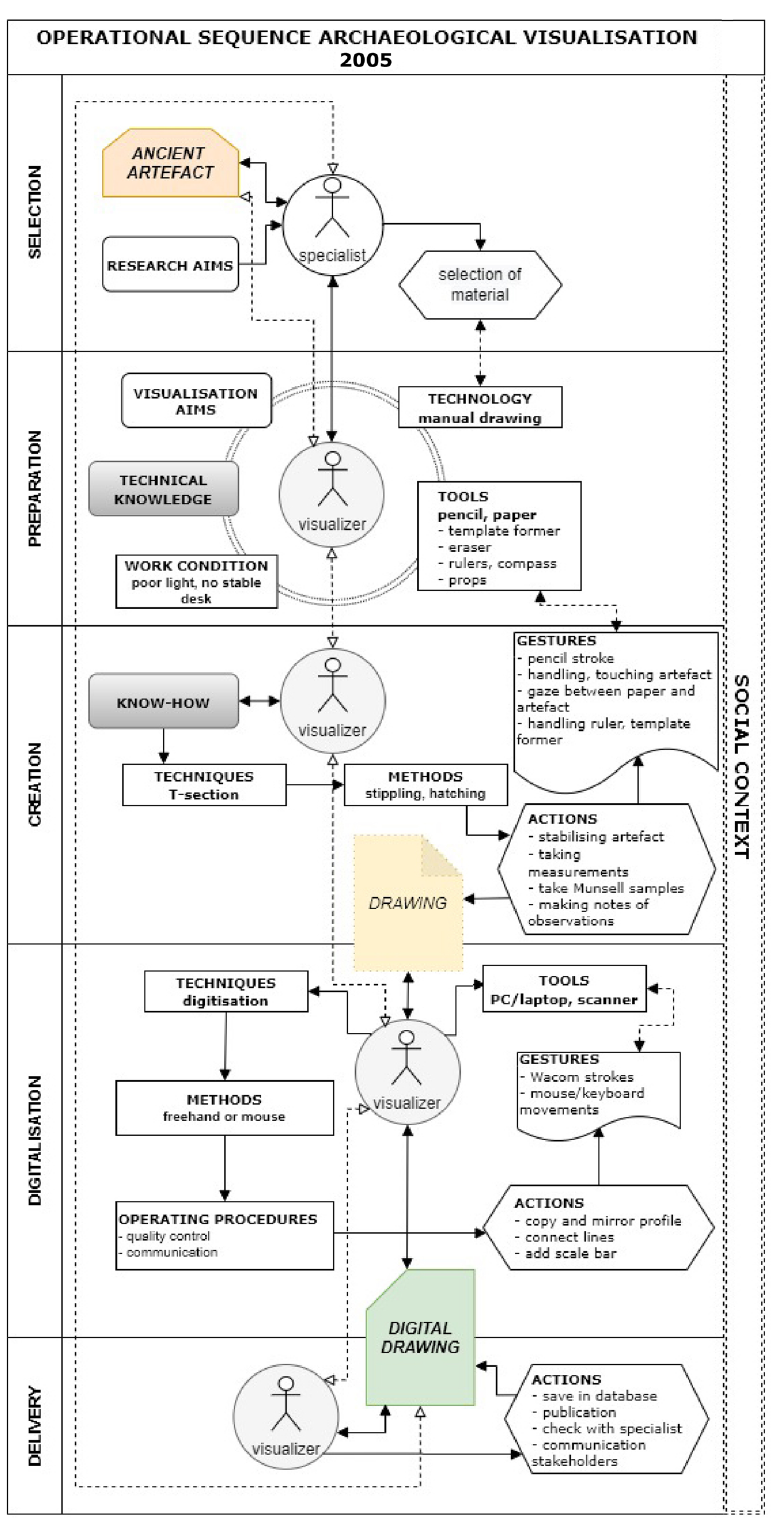
Figure 2: The operational sequence of conventional archaeological visualisation in 2005. Image by the